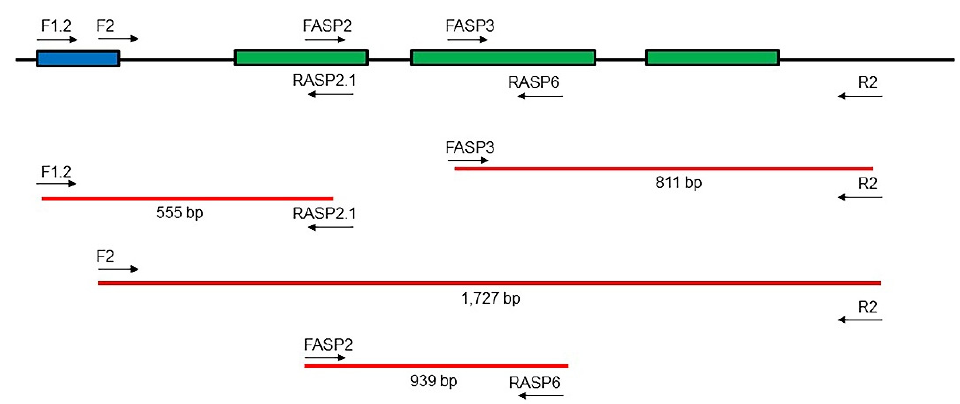
Figure 5. Synthesized degenerate primers comprising sequence prior to the start of the L-asparaginase gene (blue), flanking regions, L-asparaginase gene (green) with introns, sequence posterior to the L-asparaginase gene and the alignment of primers for the identification of the L-asparaginase gene from P. sizovae (red).